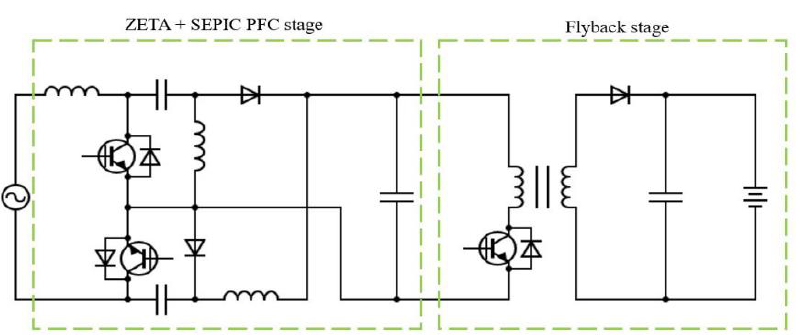
Figure 7. Flyback converter with Zeta-SEPIC PFC stage [37].